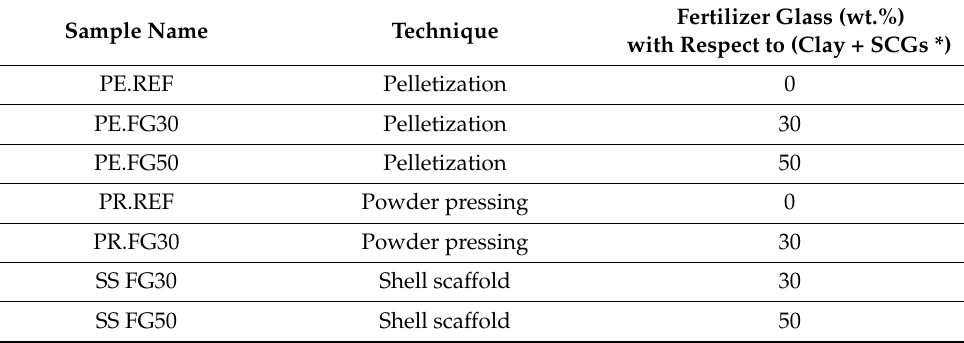
Table 1. Silica porous samples obtained by the different